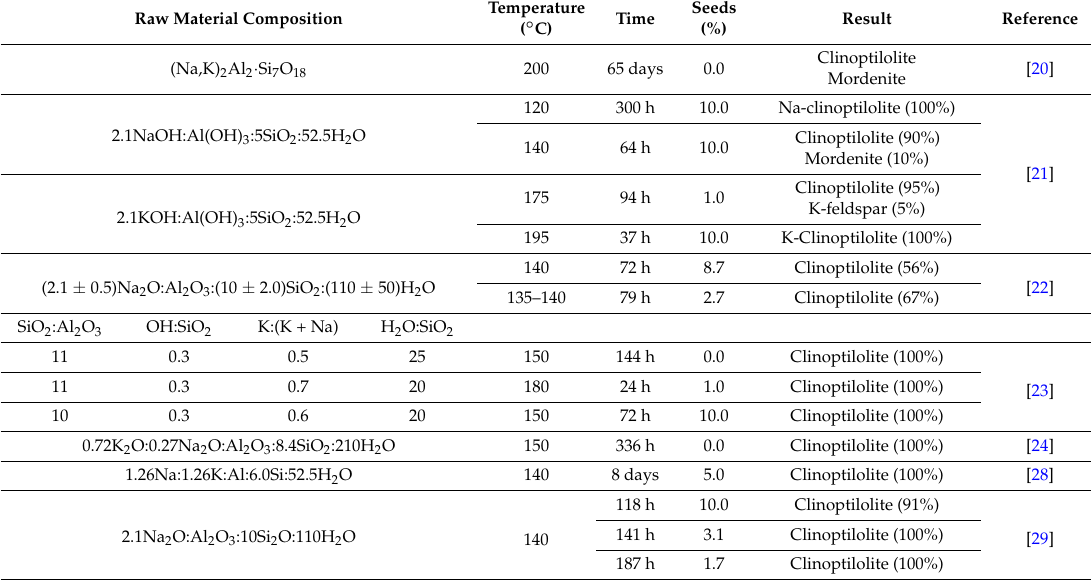
Table 1. Experimental condition of clinoptilolite